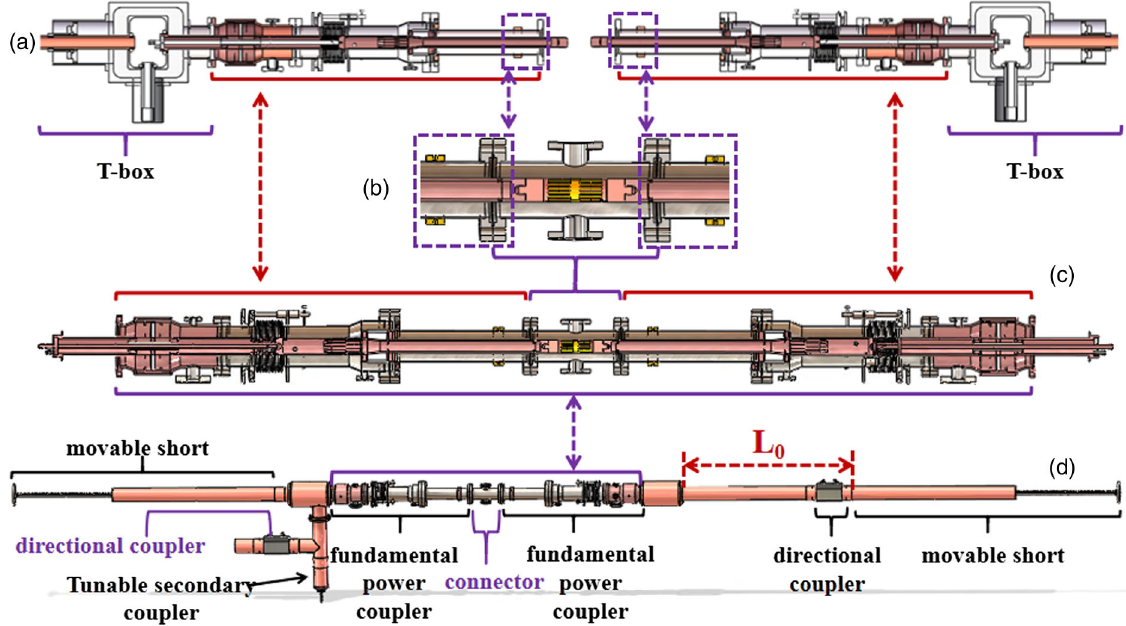
FIG. 3. Mechanical drawings of the movable SW resonant test scheme: (a) the fundamental power couplers; (b) the coaxial connector; (c) the conjunction of two fundamental power couplers; and (d) the mechanical diagram of the test